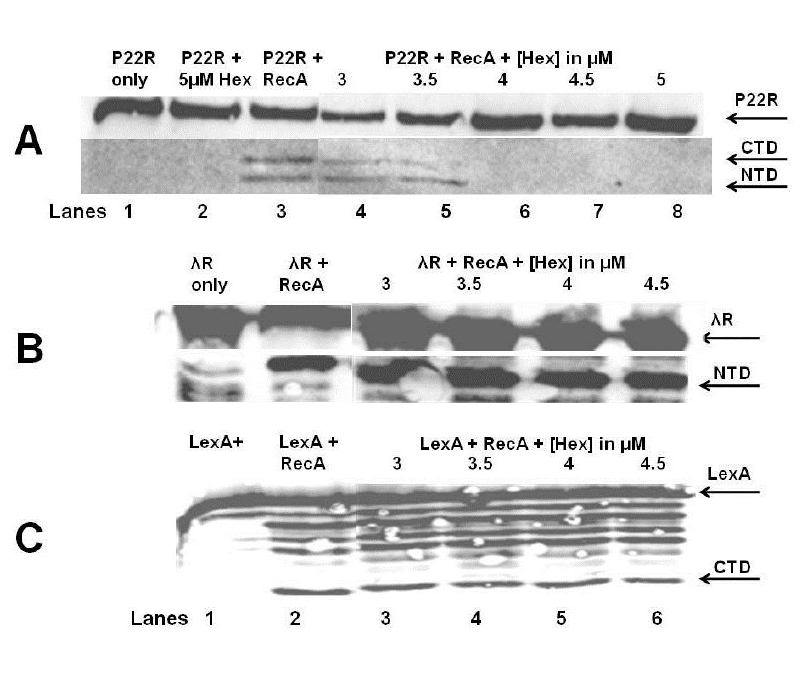
Figure 8. Effect of Hex on RecA-stimulated autocleavage of bacteriophage and bacterial repressors. Bacteriophage repressors from phage P22 ( A ), λ ( B ), and the bacterial SOS repressor LexA ( C ) were incubated in the absence (lane1) or presence of indicated concentrations of sHex and/or 5 µM RecA. The figure is a composite immunoblot of the reaction products reacted with anti-protein antibodies and visualized by